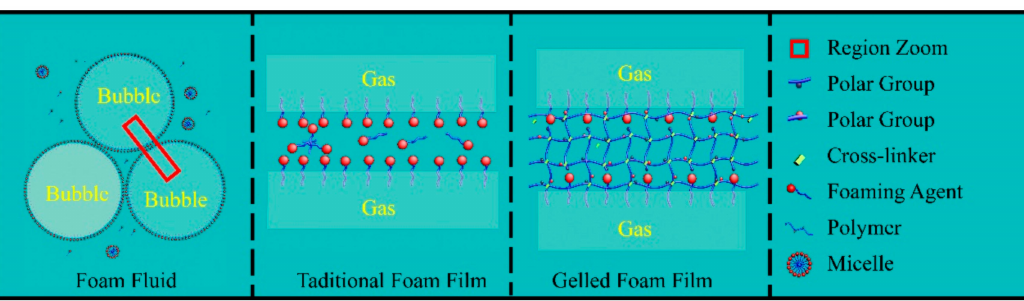
Figure 8. Microstructures of the gelled foam and traditional foam: ( a ) traditional foam (10 × ); ( b ) traditional foam (20 × ); ( c ) gelled foam (10 × ); ( d ) gelled foam (20 × )).